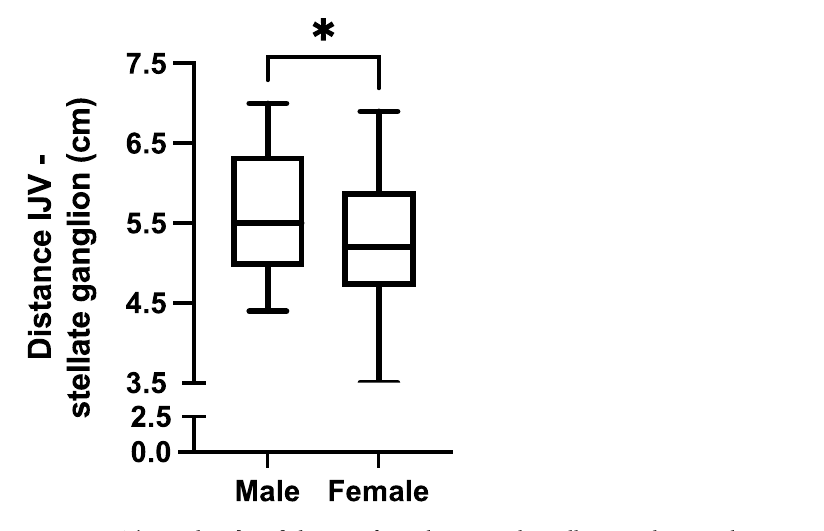
Figure 5. The median [IQR] distance from the IJV to the stellate ganglion was longer in male body donors (5.5 [4.95–6.35] cm) than in female body donors (5.2 [4.7–5.9] cm; *p = 0.0304, unpaired